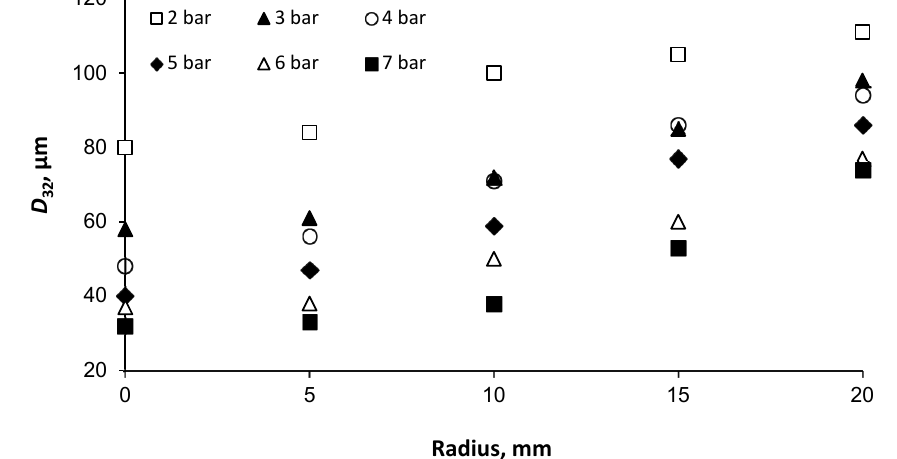
Figure 5. Distribution of D 32 drop diameters over the radius of the spray torch.